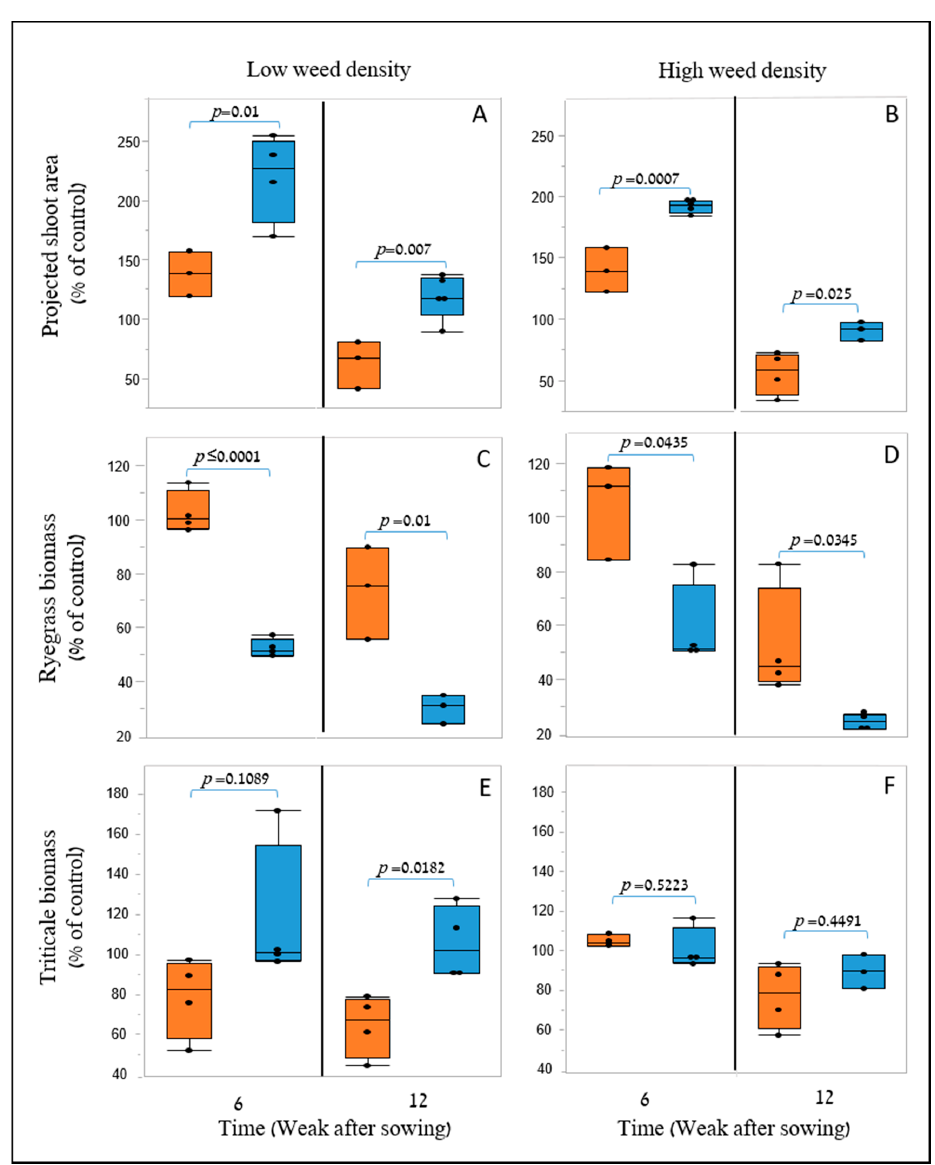
Figure 8. Results of the controlled conditions competition experiment under low (left, A , C , E ) and high (right, B , D , F ) Lolium multiflorum (ryegrass) density levels. ( A , B ) X-1010 ( blue ) and Triticale1 ( orange ) projected shoot area, ( C , D ) ryegrass shoot biomass, and ( E , F ) triticale genotypes shoot biomass p -values were determined by t -test ( n = 6) between the X-1010 and the Triticale1 genotype.